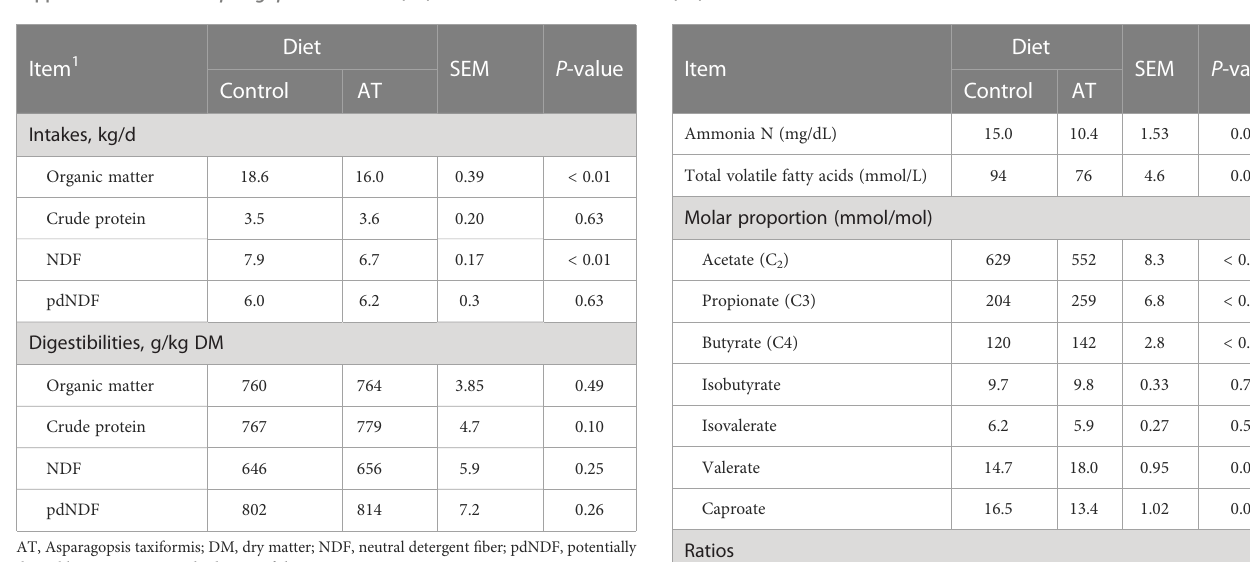
TABLE 4 Intakes and digestibilities of dietary chemical components for cows fed a grass silage-based diet without (control) or with supplementation with Asparagopsis taxiformis (AT).